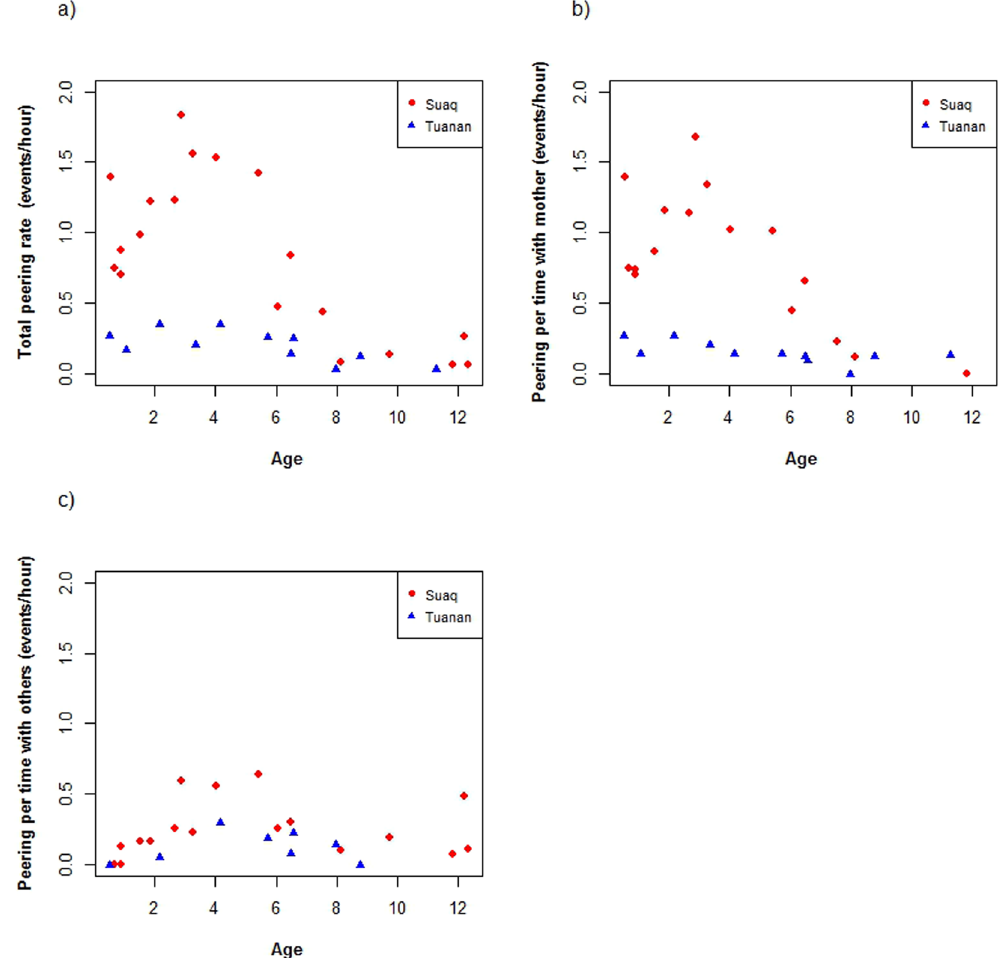
Figure 2. Average total peering rates (peering events per hour) versus age in years ( a ). Peering at the mother, corrected for time spent with her (peering events at the mother per hour spent with her) versus age ( b ). Peering at the other individuals, corrected for the time spent with them (peering events at other individuals than the mother per hour spent with them) versus age ( c